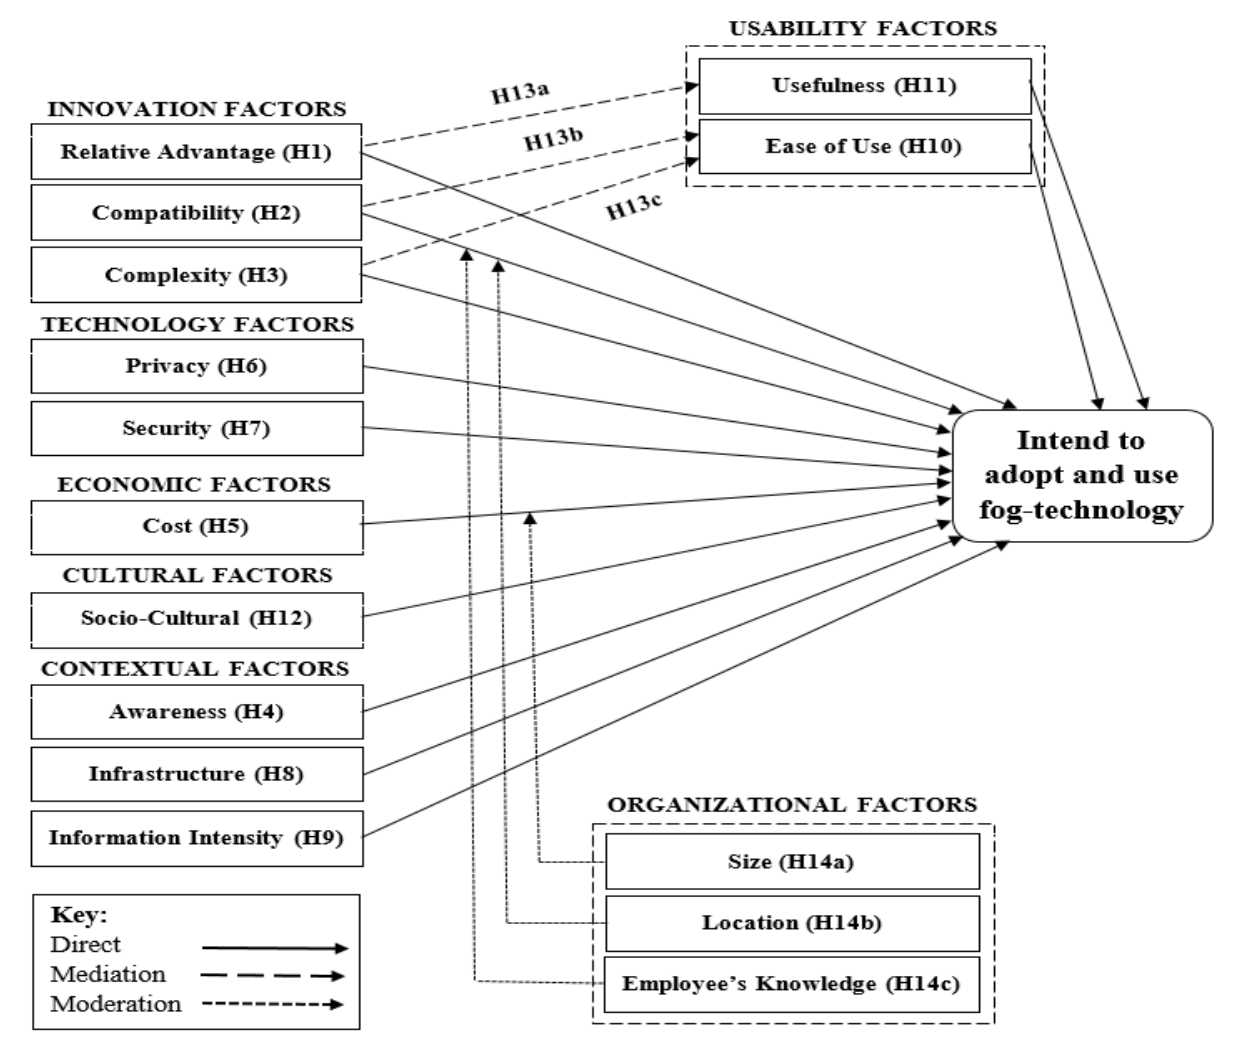
Figure 1. The fog conceptual research framework.